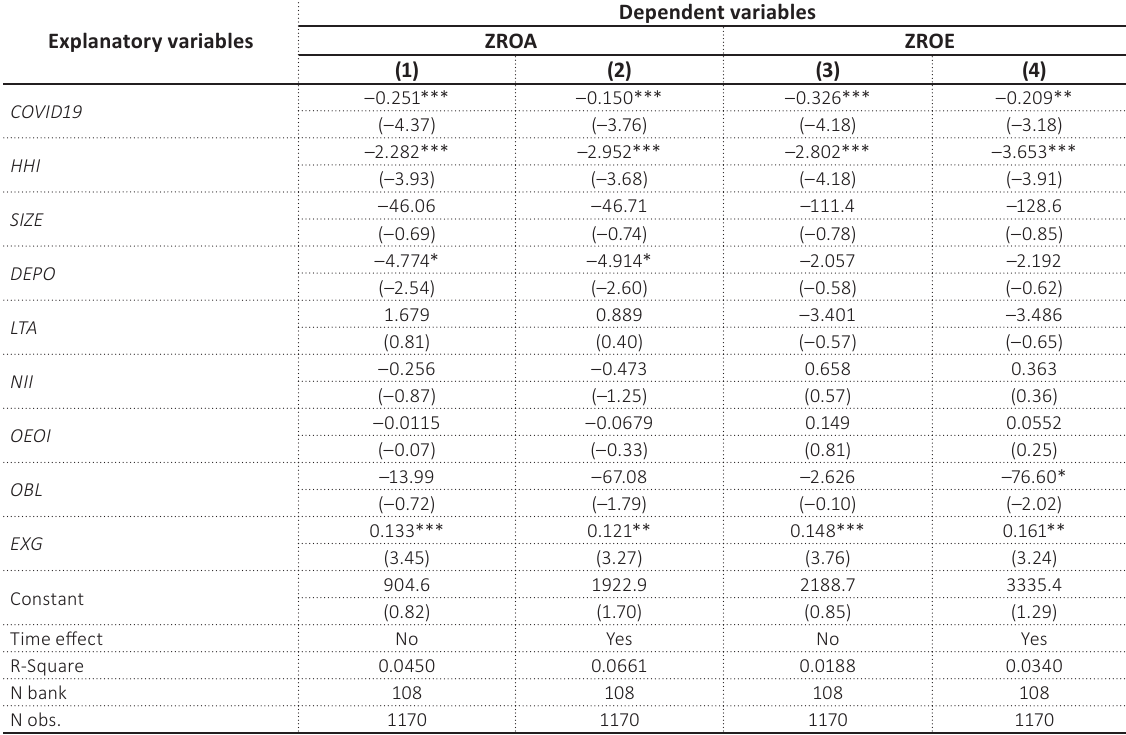
Table 3. COVID-19 and bank stability – baseline regression